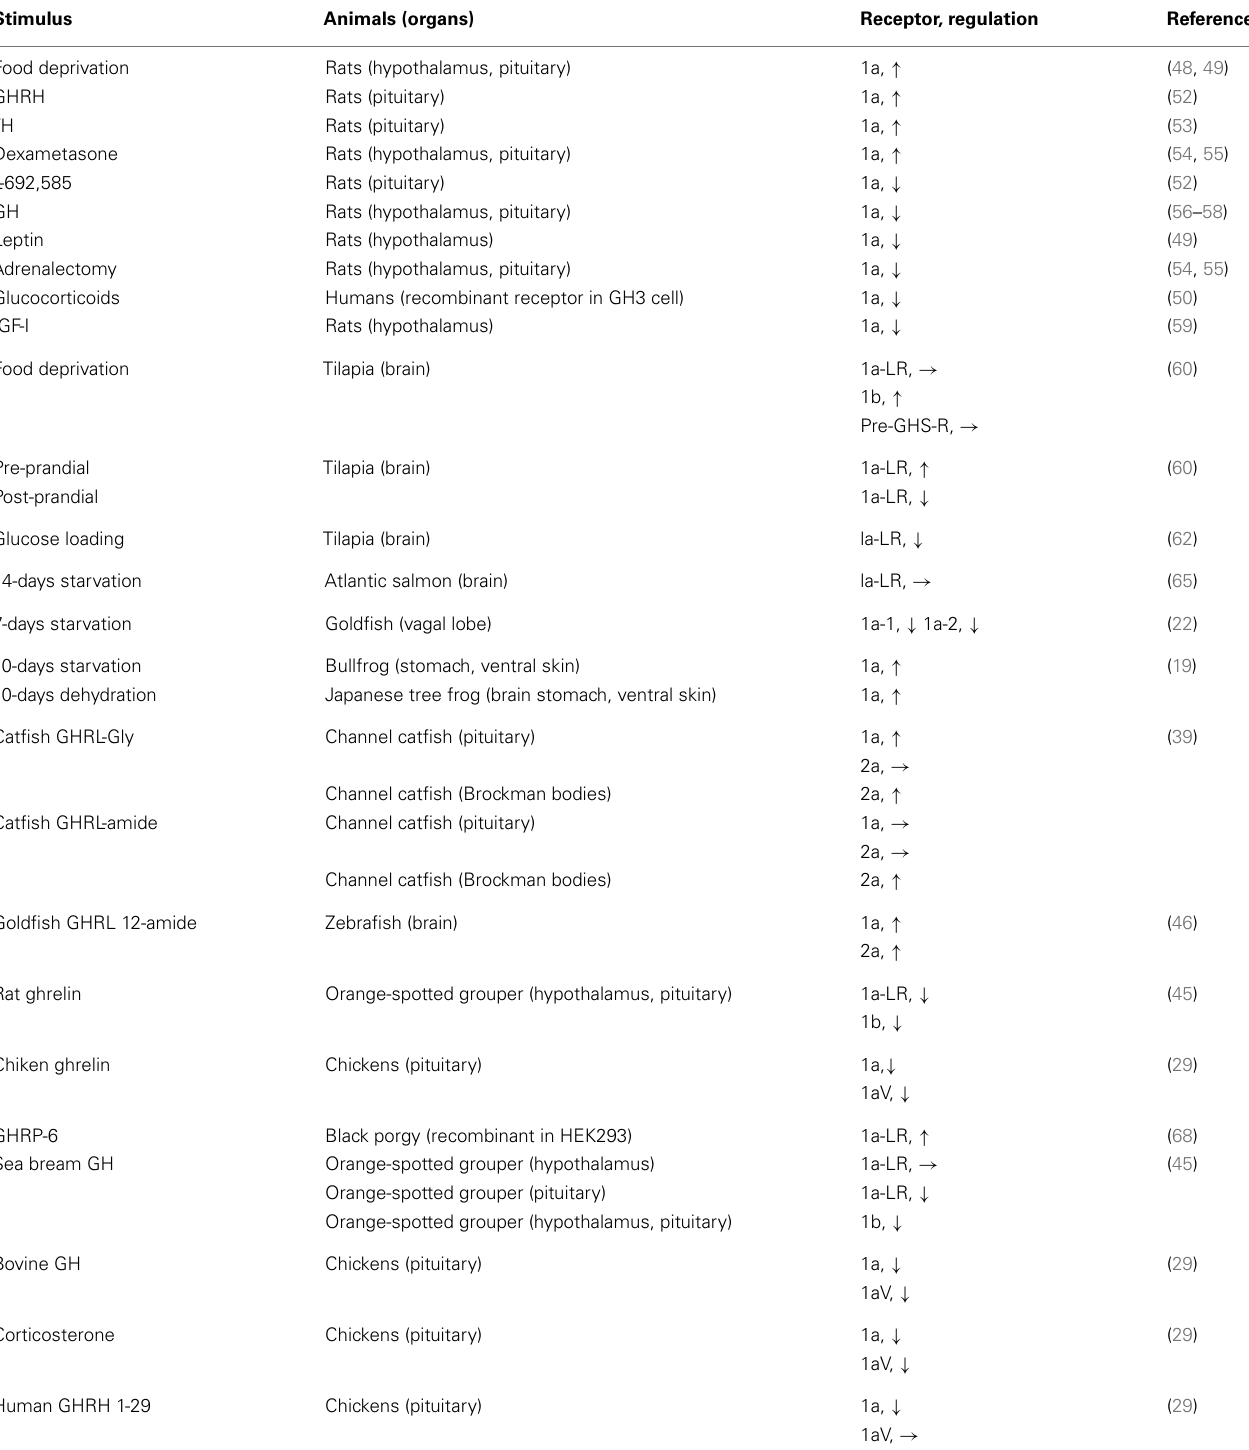
Table 3 | Regulation of ghrelin receptor